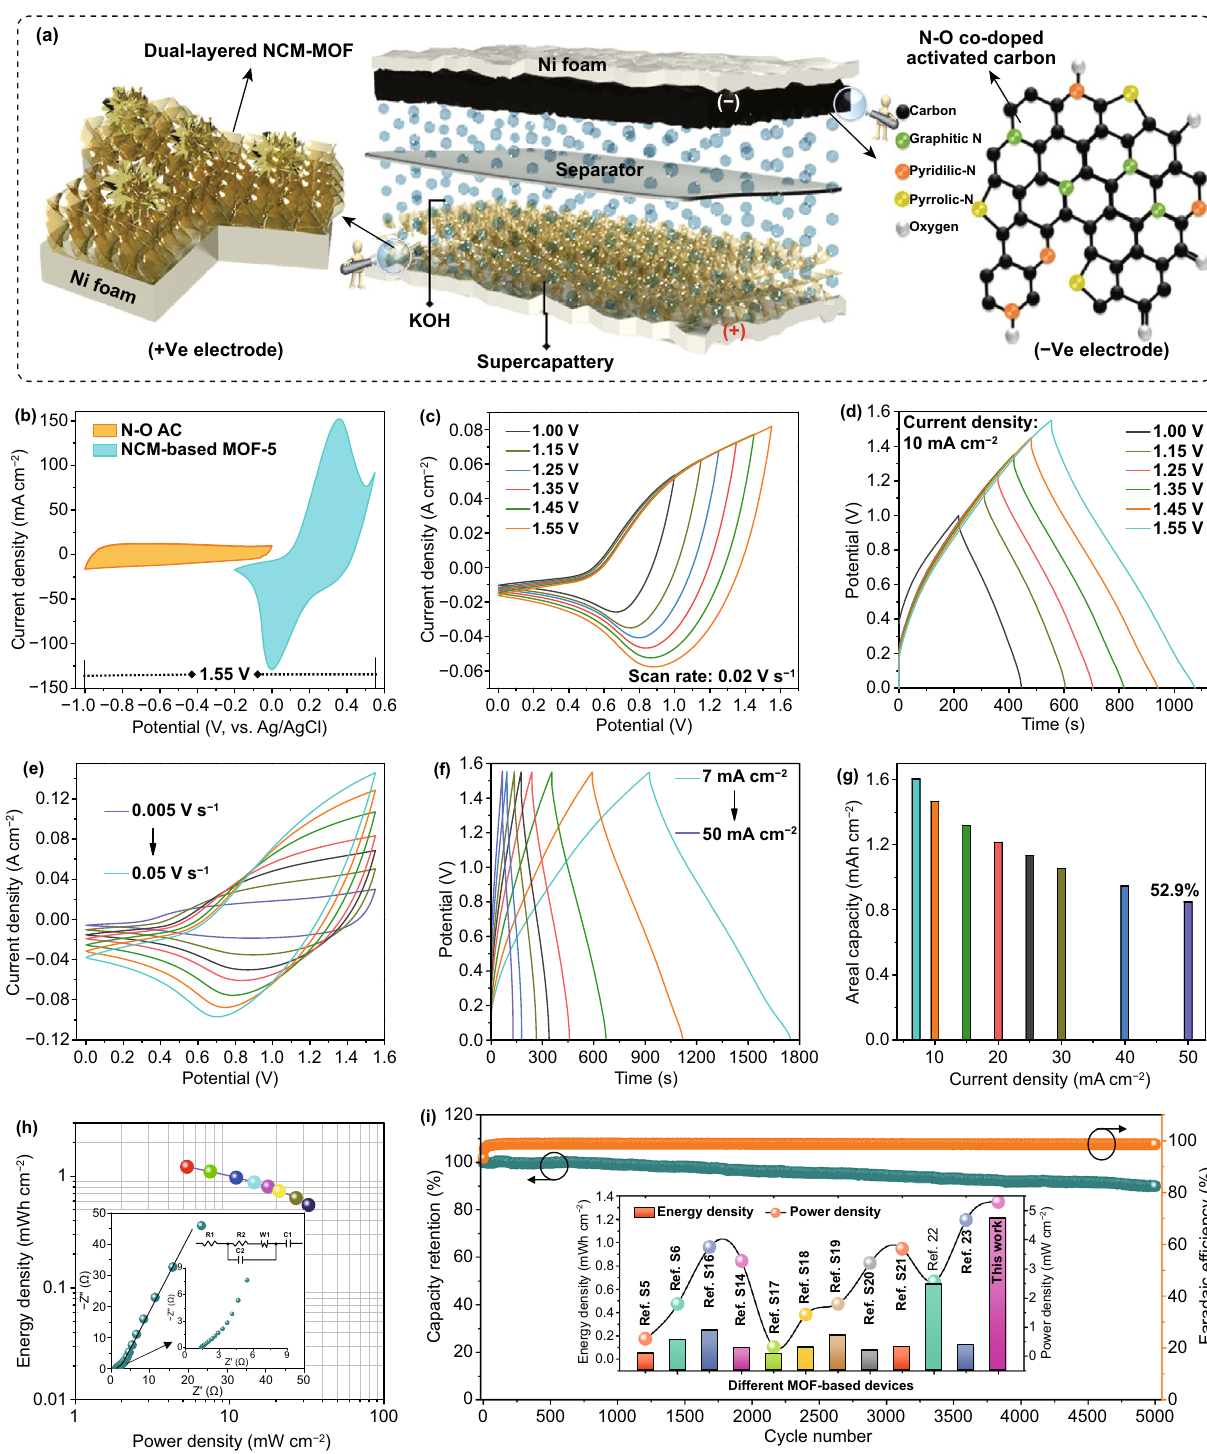
Fig. 6 a Schematic illustration showing the fabrication of supercapttery device and b CV curves of the dual-layered NCM-based MOF-5 and biomass-derived N–O AC electrodes measured individually at a scan rate of 0.01 V s −1 , indicating the possible cell potential of 1.55 V. c CV and d GCD curves of NCM-based MOF- 5//N–O AC device measured at various potential windows of 0–1.0 to 0–1.55 V. e CV curves and f GCD curves of the supercapattery system measured at various scan rates and current densities of 0.005–0.05 V s −1 and 7–50 mA cm −2 , respectively. g Calculated areal capacity response with respect to the applied discharge cur- rent density. h Ragone plot and i cycling stability of the supercapttery. The insets in h and i show the Nyquist plot of the fabricated device and comparative energy and power densities of various supercapattery devices with previous works,